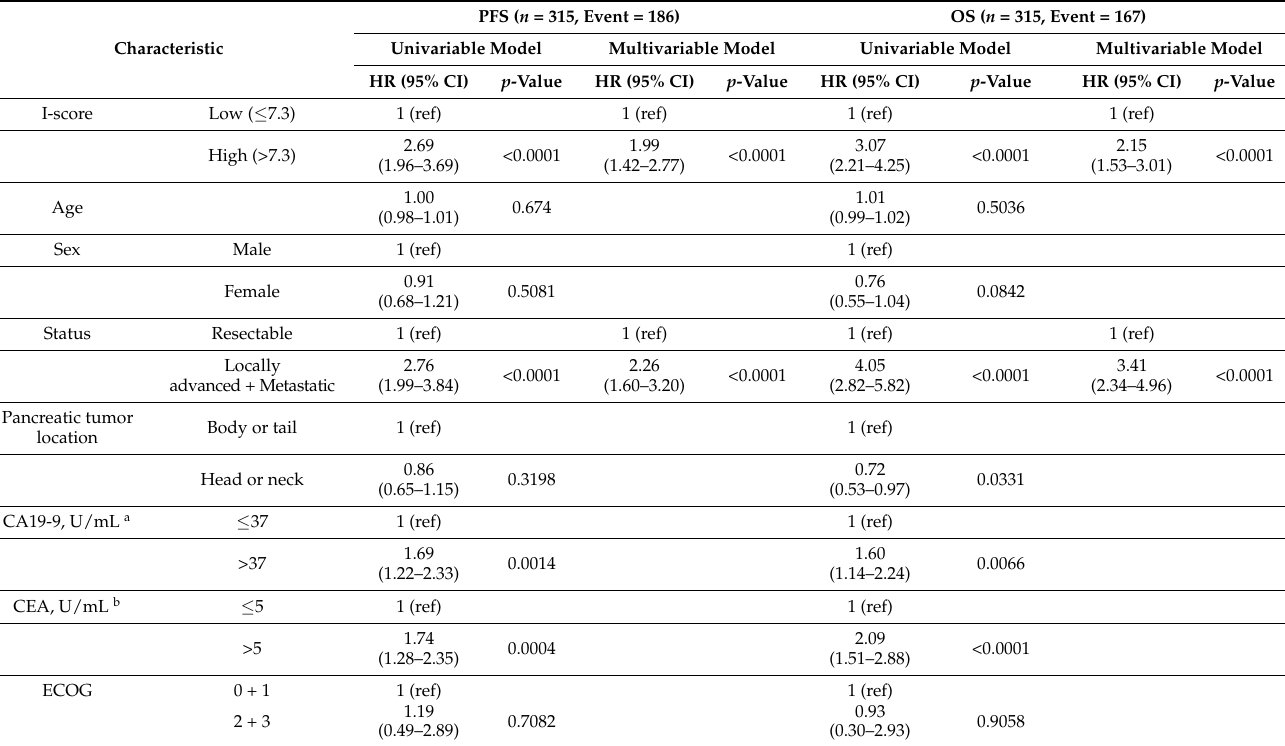
Table 2. Univariable and multivariable analyses of OS and PFS for I-score and clinical